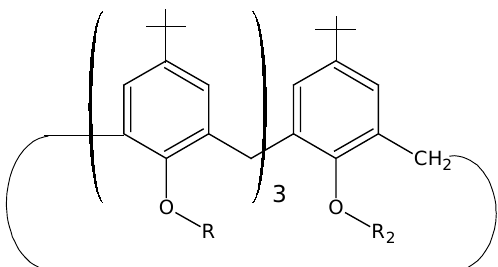
Figure 14. Calix[4]arene as a sutiable neutral carrier for Na + selective electrode. 1. R 3 R 4 R 5 R